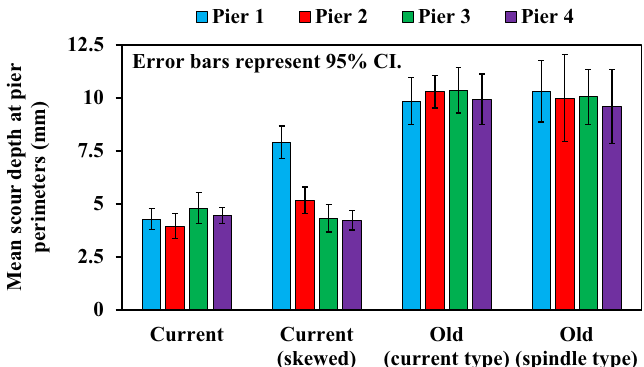
Figure 14. Mean scour depth at pier perimeters for the five